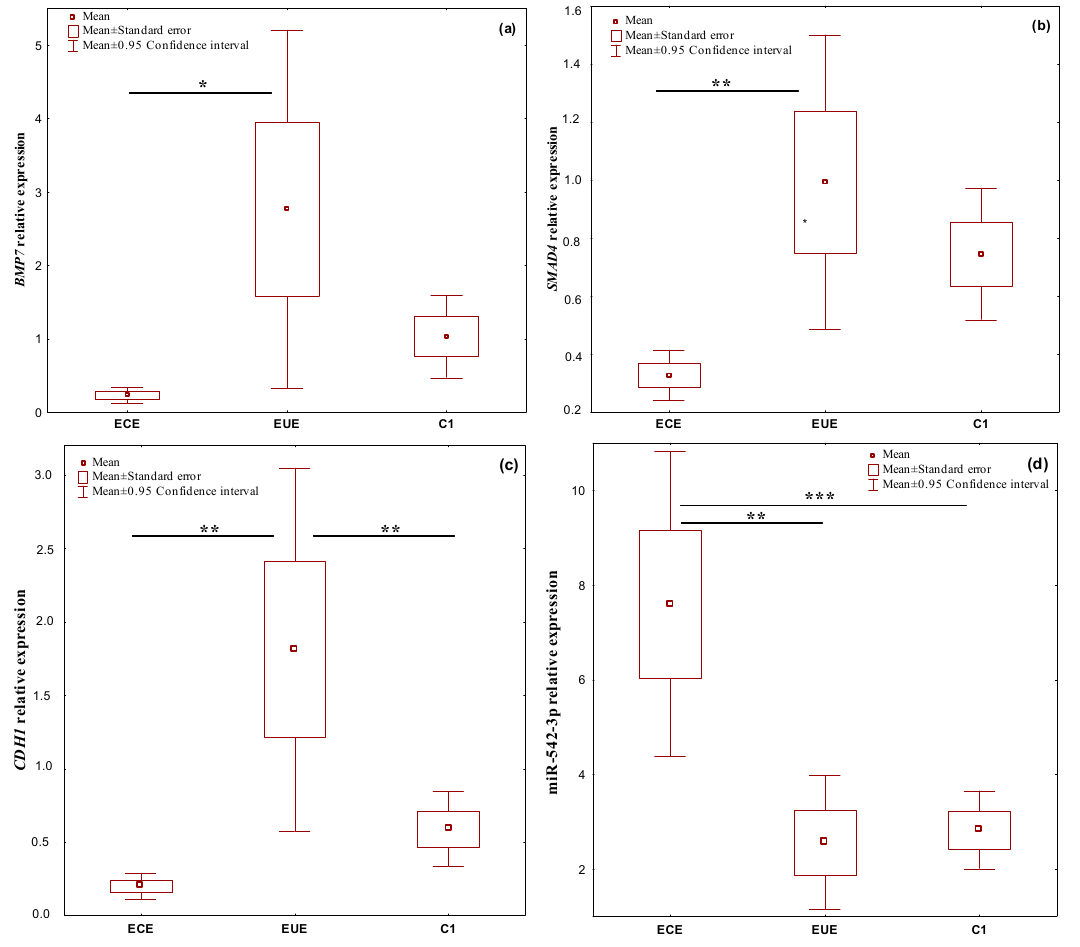
Figure 1. The expression levels (mean RQ values) of the genes ( a ) BMP7 , ( b ) SMAD4 , ( c ) CDH1, and ( d ) miRNA-542-3p in individual tissue materials (sources of tissue: ectopic endometrium—ECE and eutopic endometrium—EUE, obtained from the same patient with endometriosis) and control endometrium (C1). * p < 0.05, ** p < 0.01, *** p < 0.001; Neuman–Keuls’ multiple comparison test.